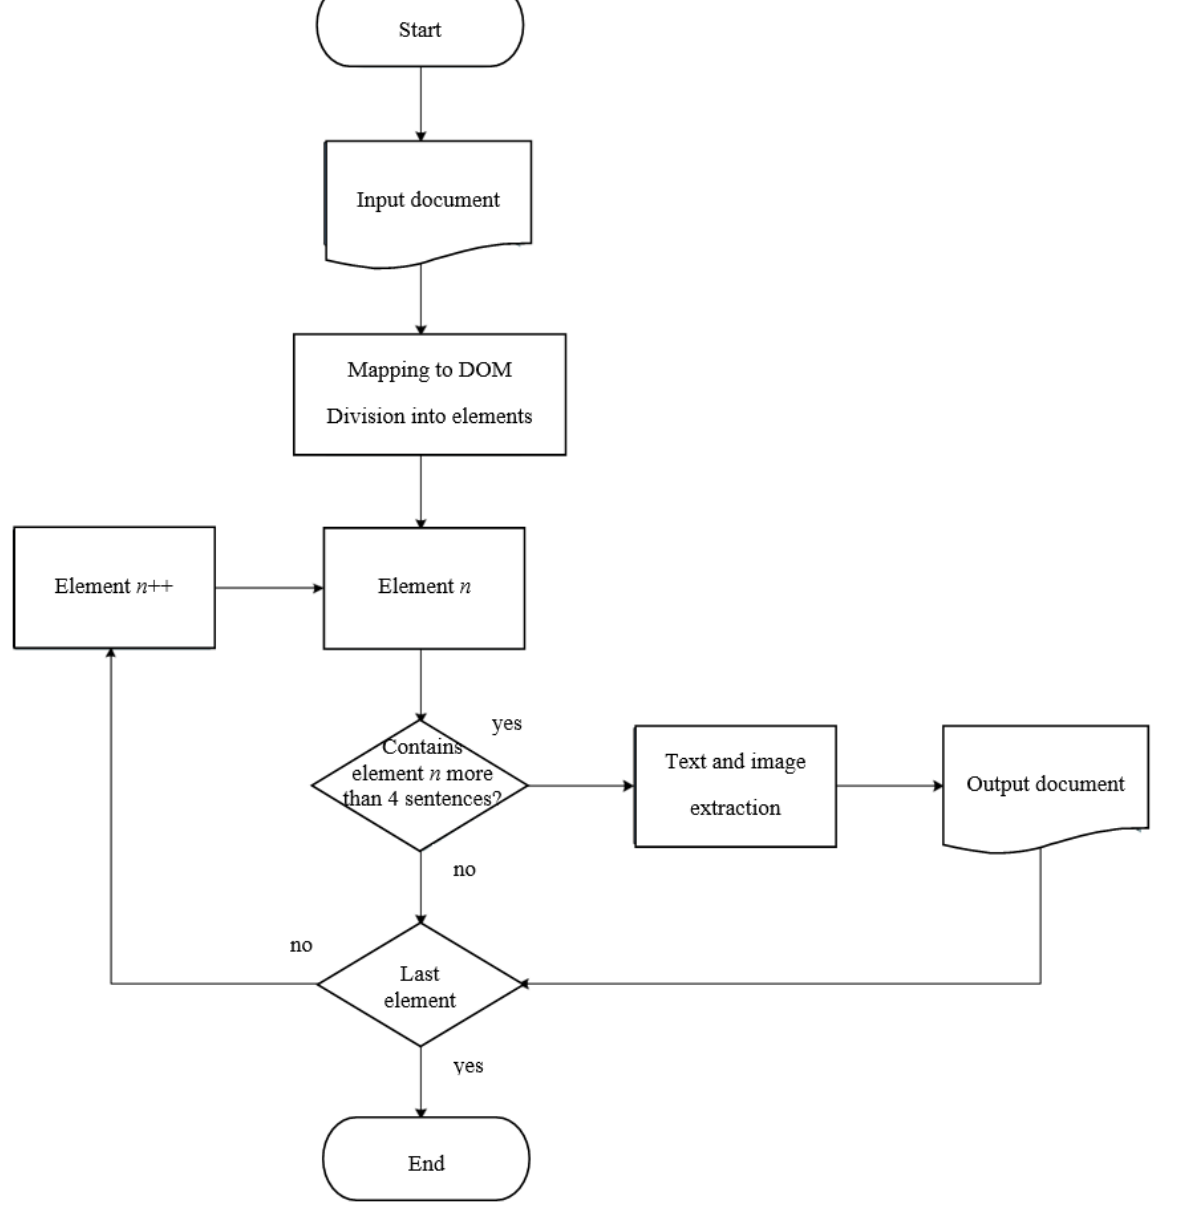
Figure 4. The flowchart for identifying the main block of a web document.